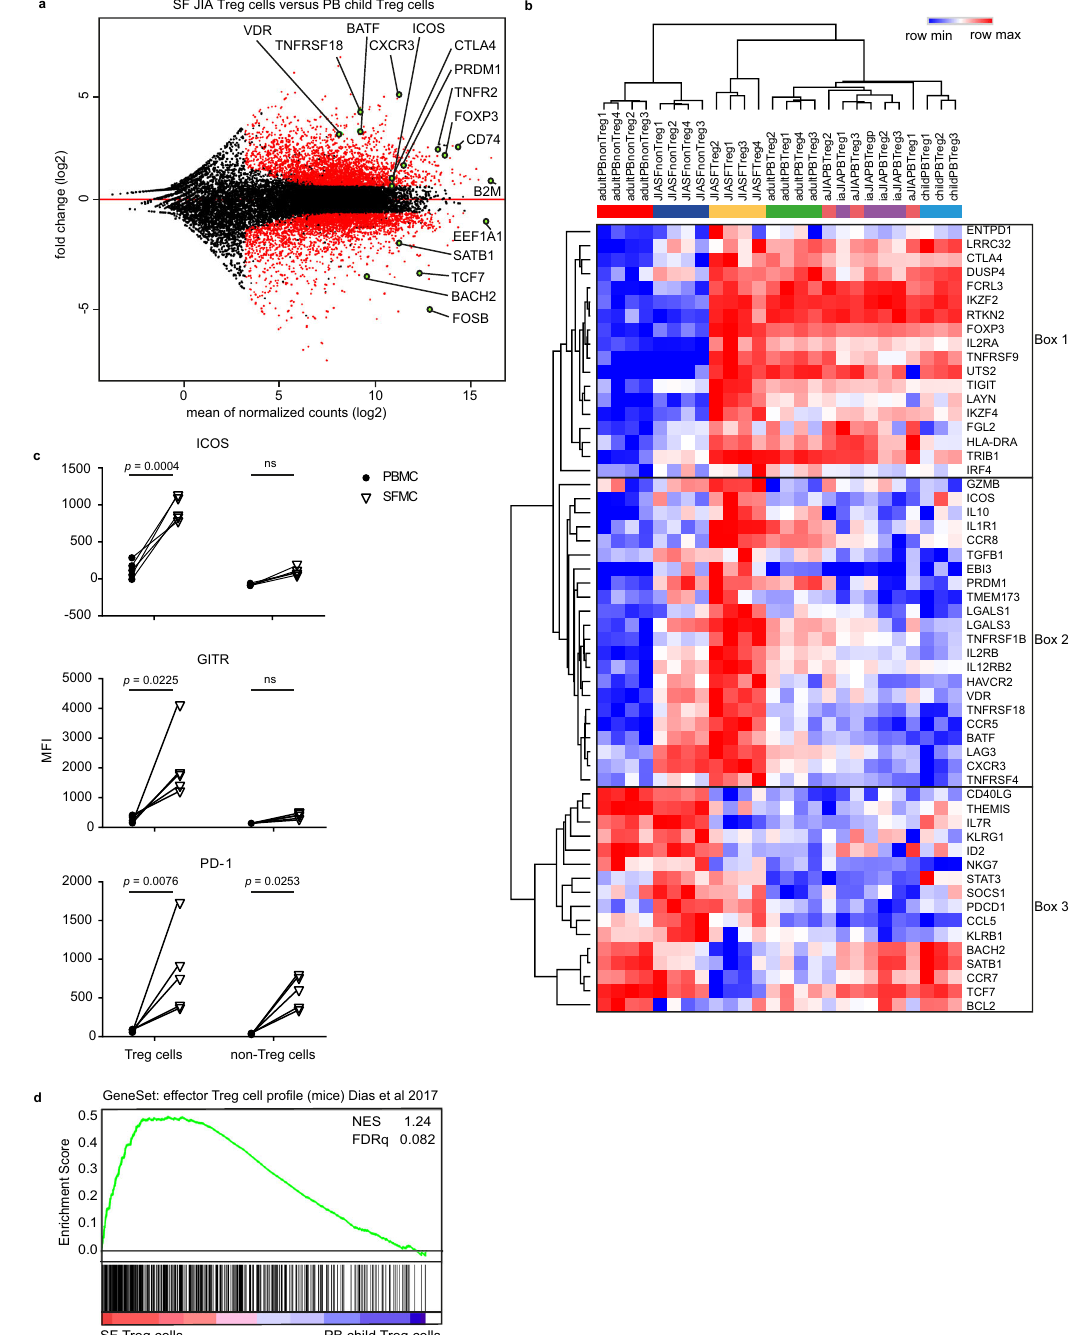
Fig. 2 In fl ammation-derived Treg cells have a speci fi c effector pro fi le. a MA plot of the differentially expressed genes between synovial fl uid (SF, n = 4) and peripheral blood (PB, n = 3) Treg cells of healthy children with black dots re fl ecting no change, and red dots transcripts with an adjusted p -value < 0.05 (corrected for multiple testing using the Benjamini and Hochberg method), minimal mean of all normalized counts >10 and log2 fold change > 0.6. b Heatmap with hierarchical clustering analysis including all groups measured with RNA-sequencing selected genes based on recent literature (relative expression of log2 RPKM). c Median Fluorescence Intensity (MFI) of ICOS, GITR, and PD-1 in gated CD3 + CD4 + CD25 + CD127 low Treg cells and CD3 + CD4 + CD25 − CD127 + non-Treg cells from paired SFMC and PBMC from 5 JIA patients. Statistical comparisons were performed using two-way ANOVA with Sidak correction for multiple testing. Data are representative of two or more independent experiments. d Gene set enrichment analysis (GSEA) of effector Treg cell genes in mice (identi fi ed by Dias et al. 53 ) in pairwise comparisons involving SF Treg cells ( n = 4) and PB Treg cells ( n = 3) derived from healthy children, represented by the normalized enrichment score (NES) and FDR statistical value (FDRq, multiple hypothesis testing using sample permutation). Source data are provided as a Source Data fi le and deposited under